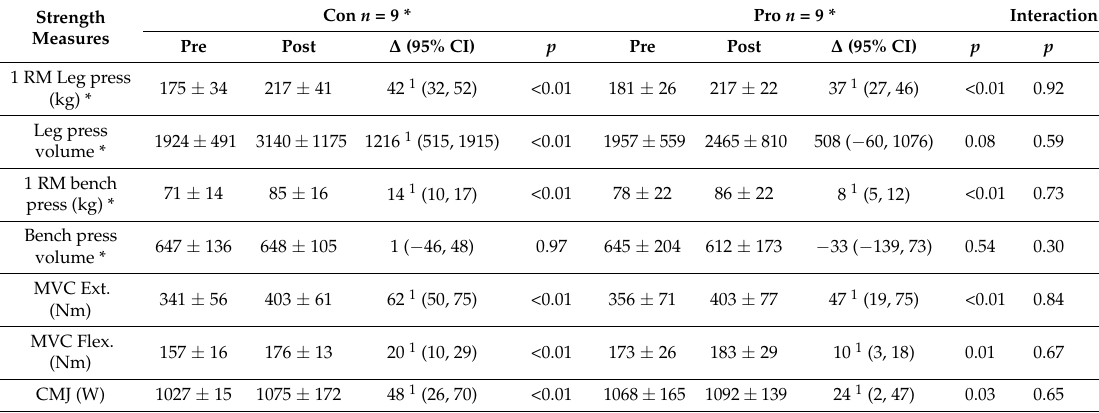
Table 4. Subjects’ strength data before (Pre) and after (Post; week 9)